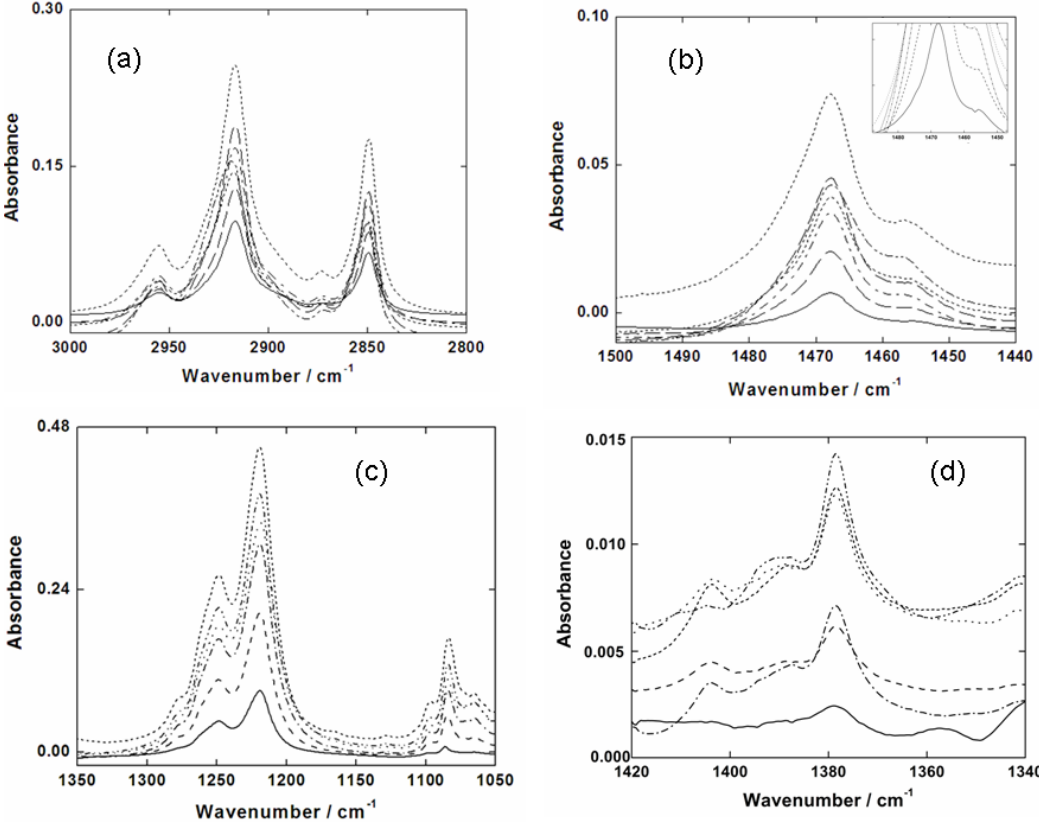
Figure 3. ( a ) The C-H stretching features for SDS molecules deposited on a Ge substrate; ( b ) The CH scissoring modes (1468 and 1456 cm − 1 ); ( c ) The SO 4= asymmetric (1248 2